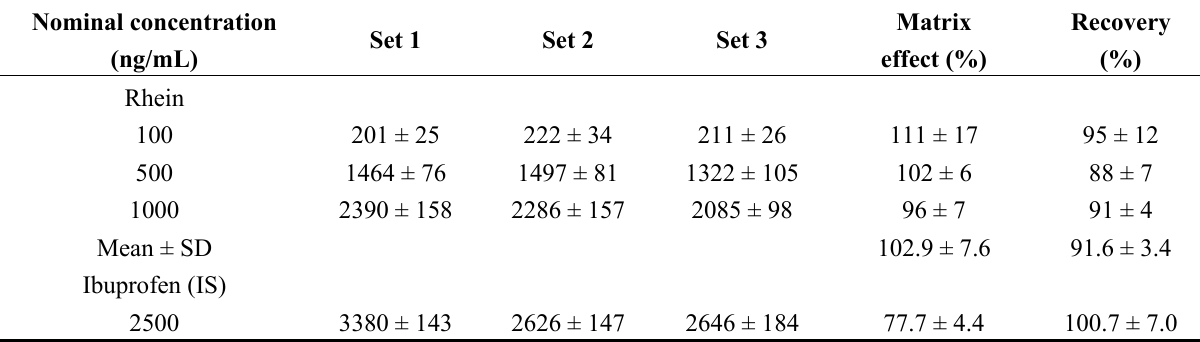
Table 3. Matrix effect and recovery of rhein and ibuprofen in rat plasma.